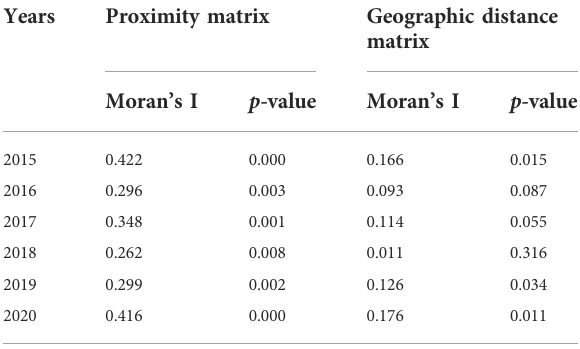
TABLE 5 2015 – 2020 proximity matrix and geographic distance matrix Moran ’ I value and p